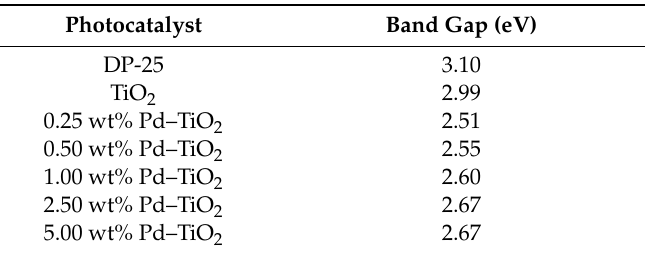
Table 4. Photocatalysts Band